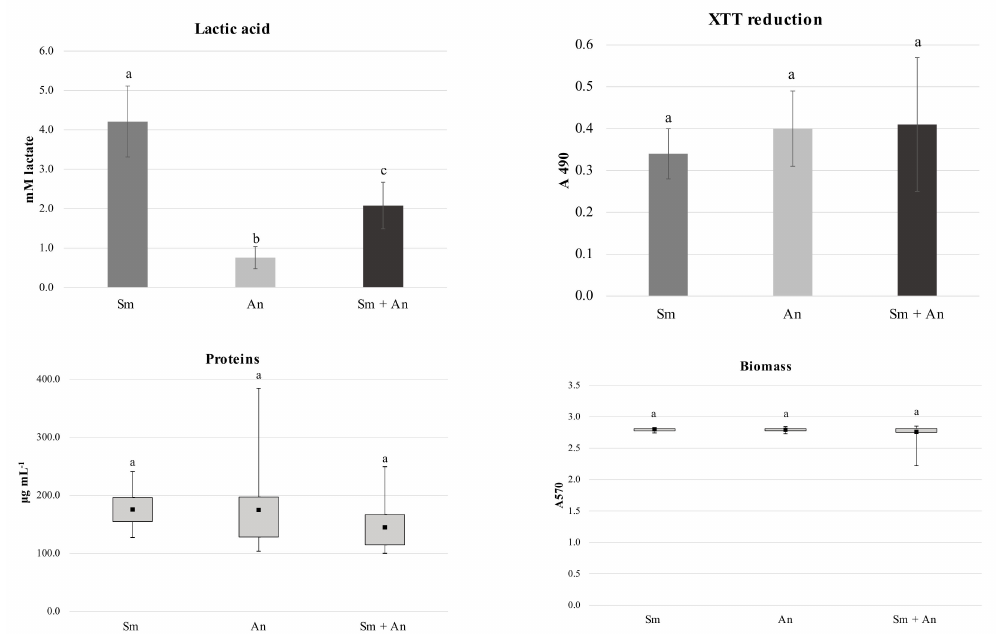
Figure 2. Characterization of single- and dual-species biofilms grown in a static model. lactic acid production, XTT reduction, and total protein concentration in biofilm matrix and biomass, according to the growth condition. Sm: Streptococcus mutans single-species biofilm; An: Actinomyces naeslundii single-species biofilm; Sm + An: S. mutans and A. naeslundii dual-species biofilm. Di ff erent letters show statistical significant di ff erences (5% significance). Lactic acid and XTT reduction: ANOVA; mean ± standard error. Proteins and biomass: Kruskal–Wallis; median and quartiles. All experiments were repeated on three independent occasions, using six discs per